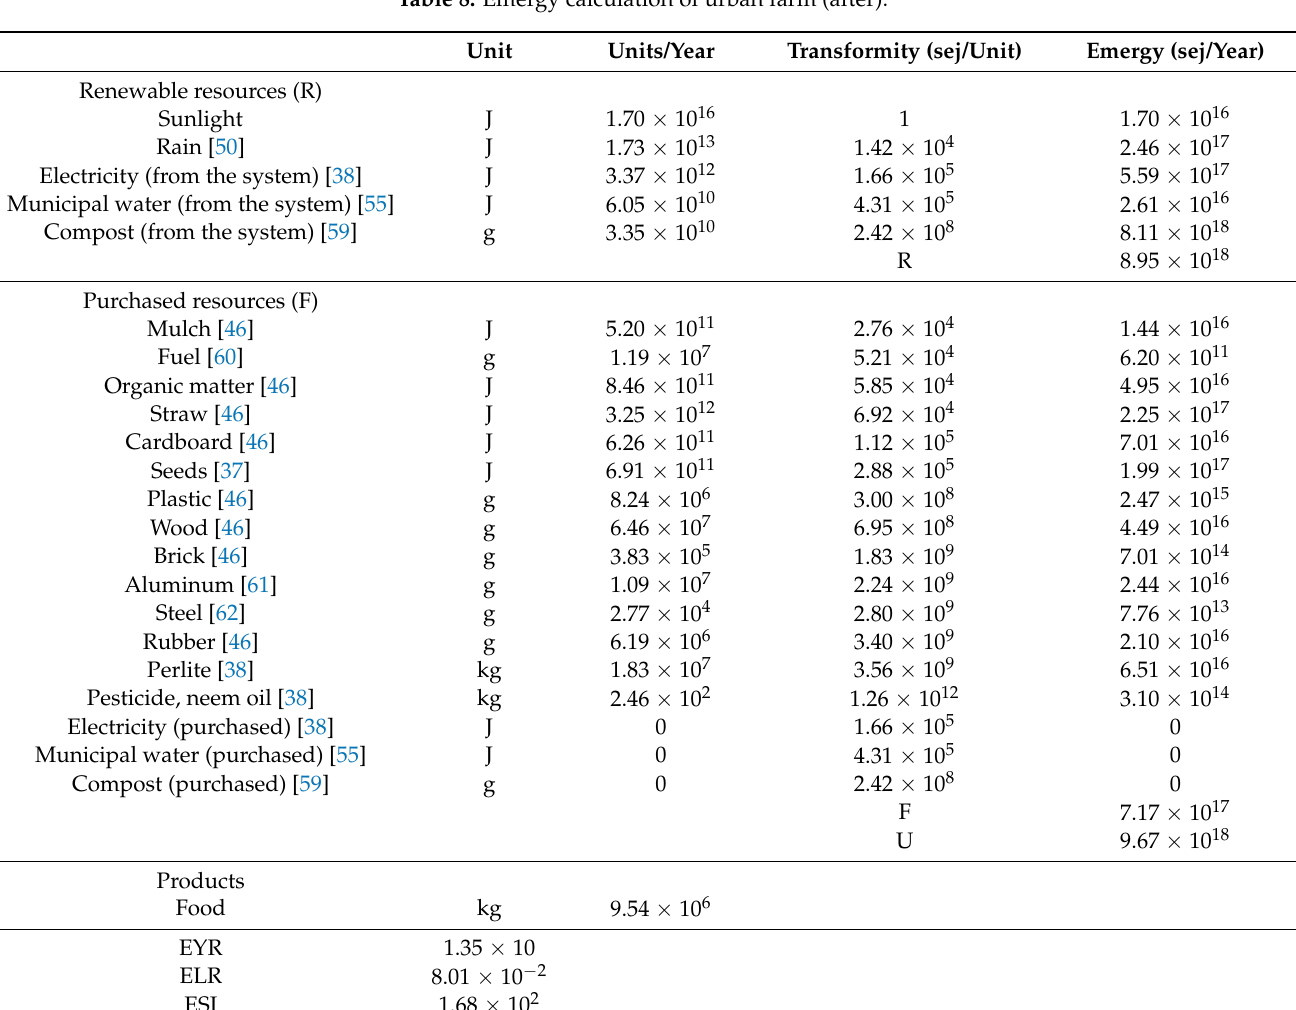
Table 8. Emergy calculation of urban farm (after).